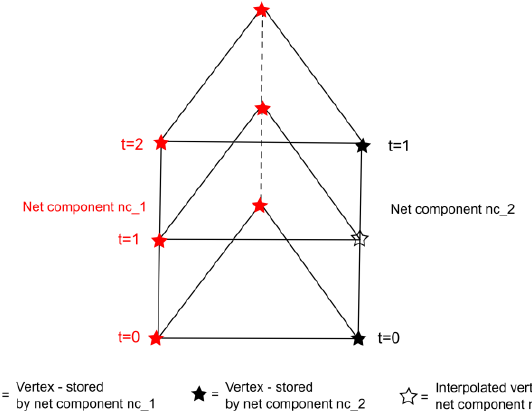
Figure 6. Spatio-temporal prism representing a shared border region